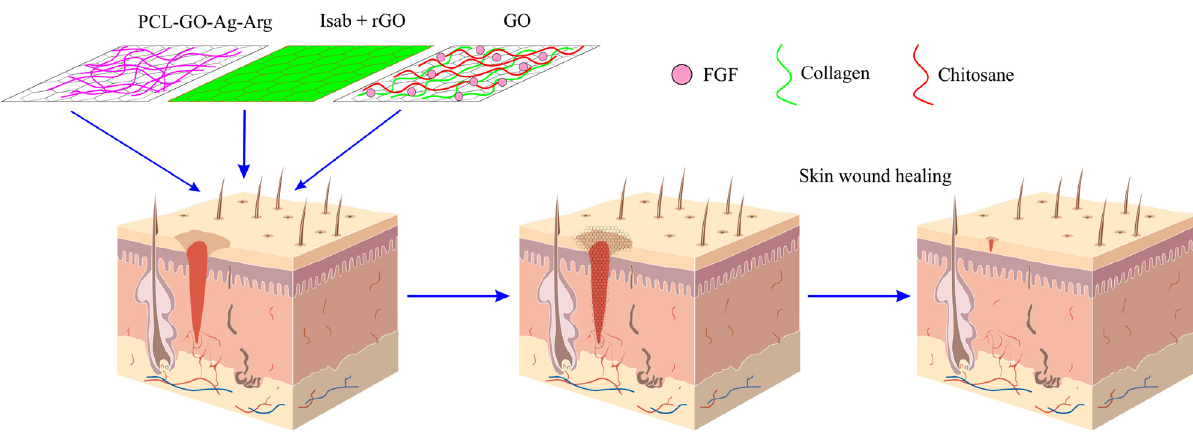
Figure 3: Applications of graphene oxide for skin